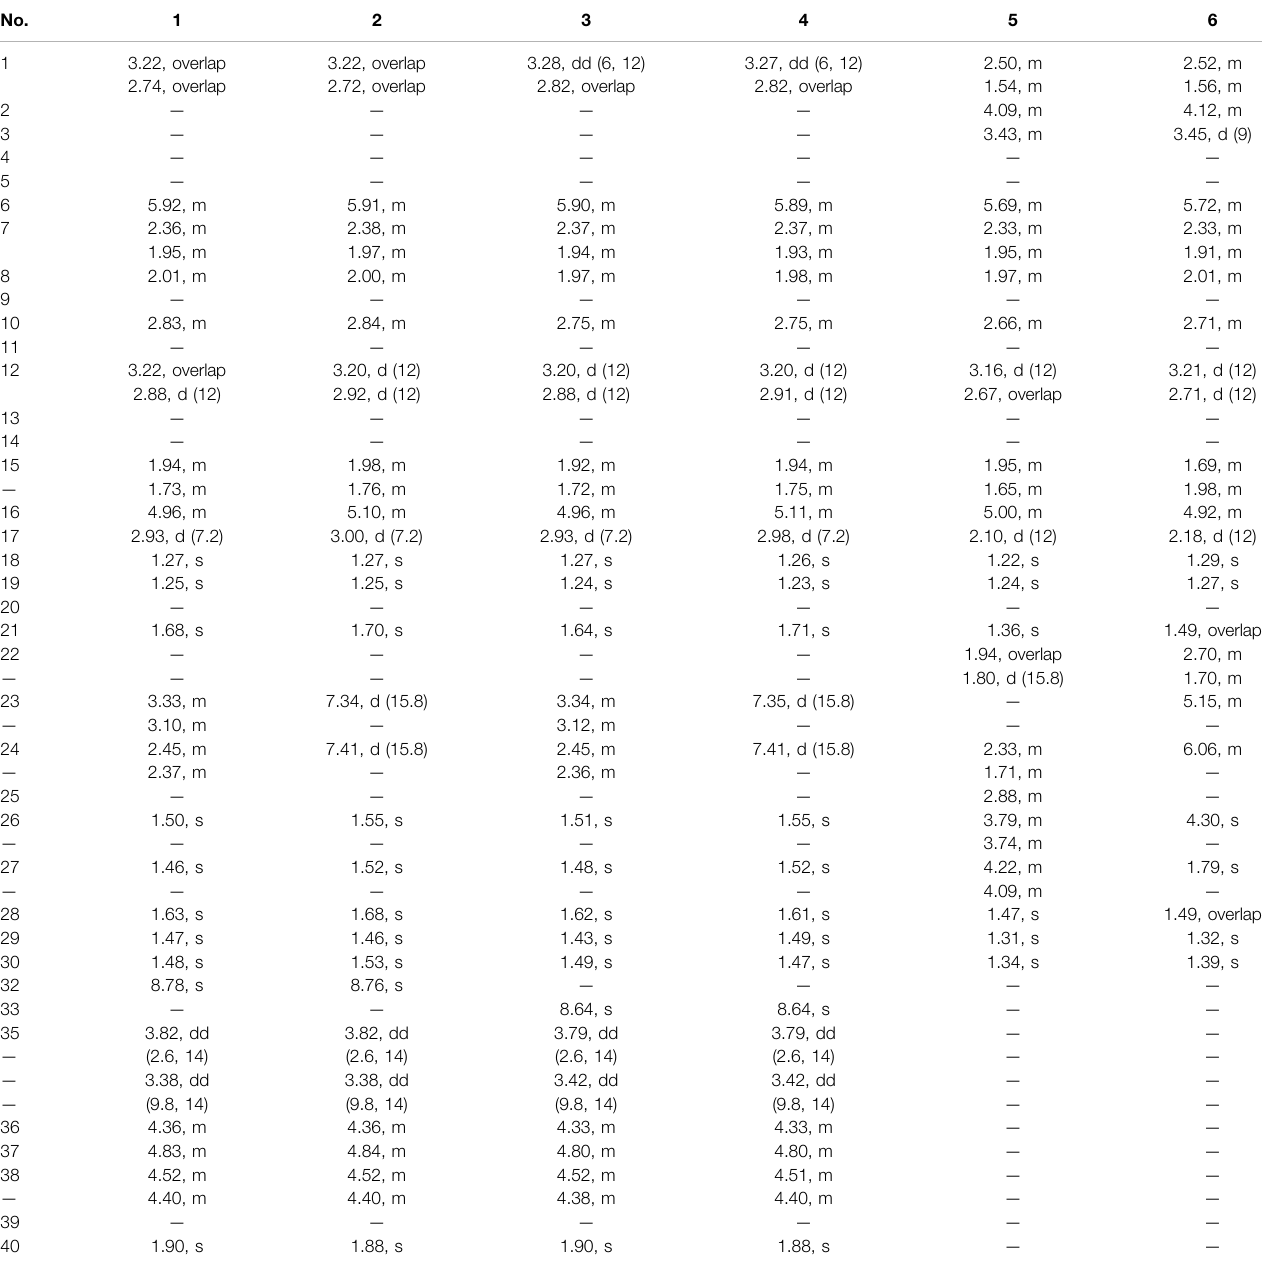
TABLE 1 | 1 H (600 MHz) NMR data of compounds 1 – 6 in pyrdine-d 5